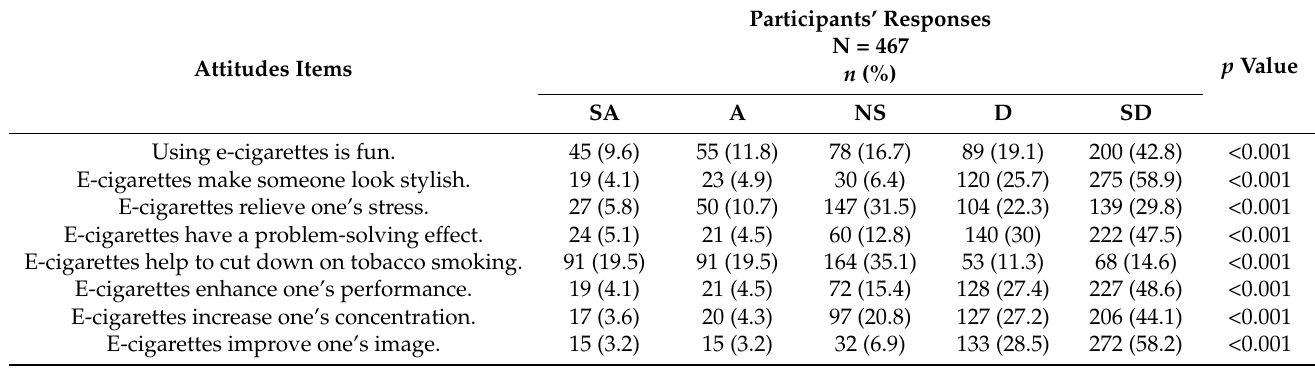
Table 4. Overall attitude towards e-cigarettes among first-year university students.